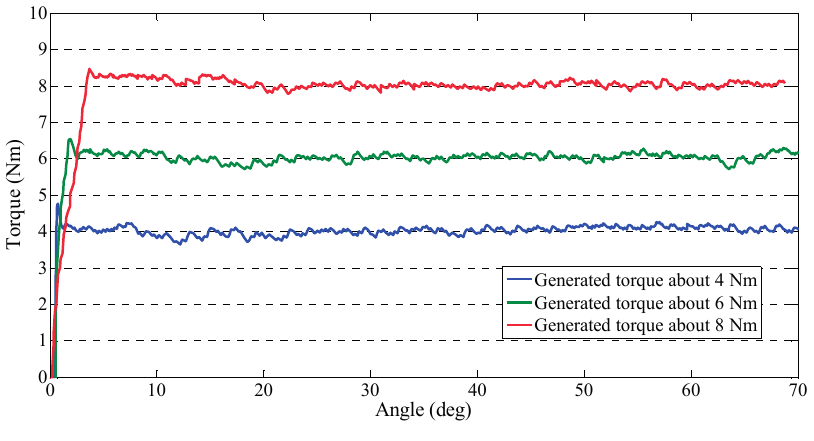
Figure 9. Constant torque from the master device.